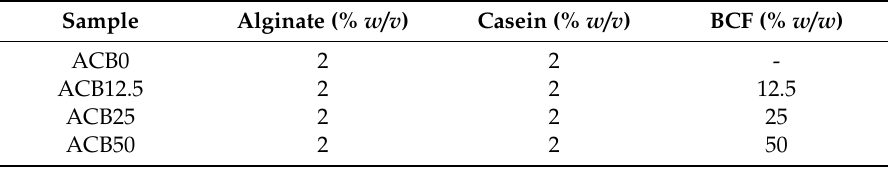
Table 1. Nomenclature and composition of prepared Alginate–Casein–BCF (ACB)